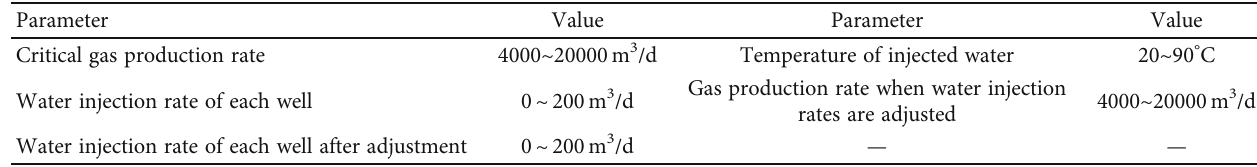
Table 3: Ranges of optimized